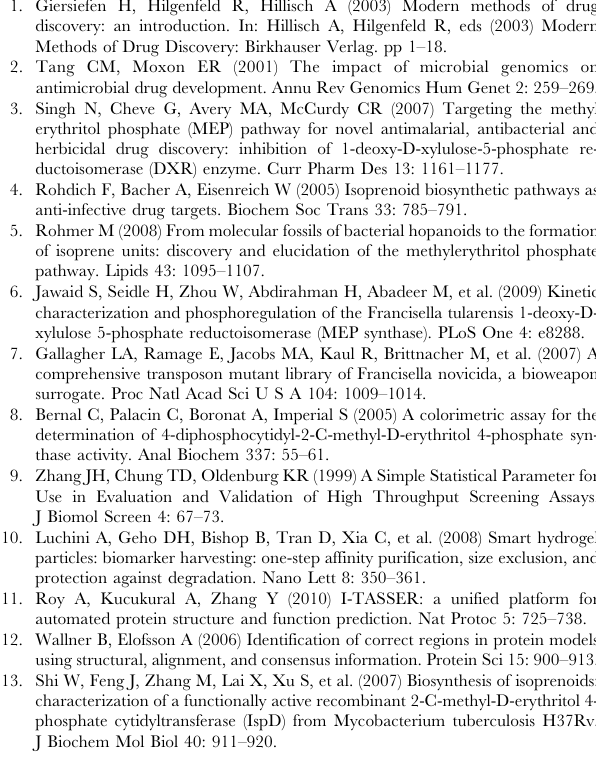
to score the model over a sliding window of 9 residues [12]. Scores range from 0 (unreliable) to 1 (reliable). (TIF)